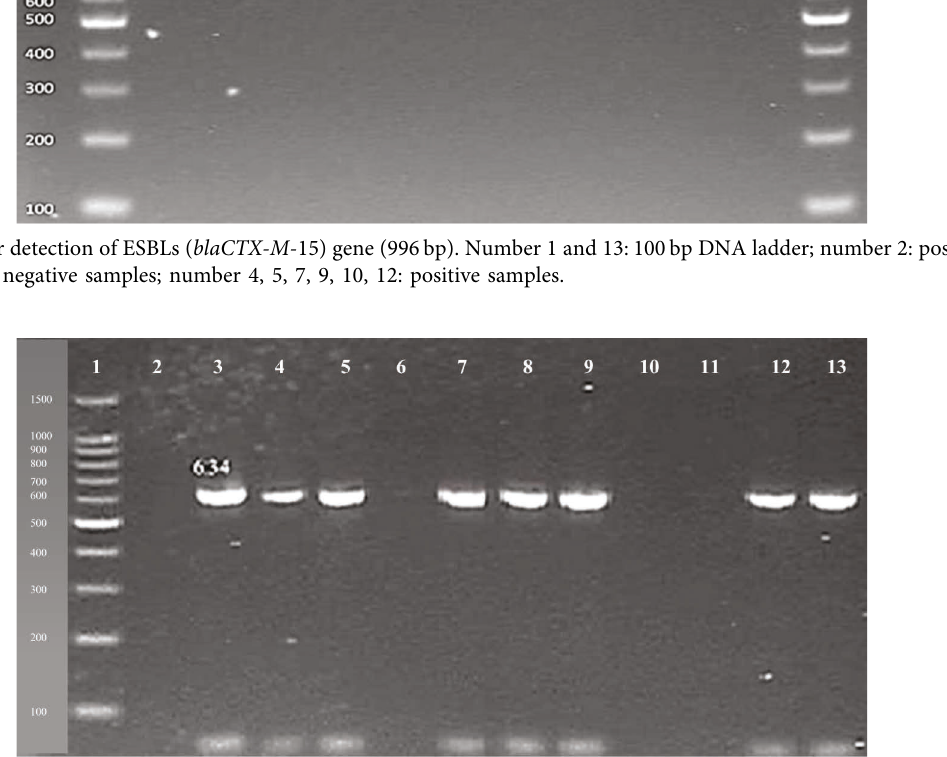
Figure 4: Molecular detection of tetB drug resistance gene (634 bp). Number 1: 100bp DNA ladder; number 2, 6, 10, 11: negative samples; number 3: positive control; number 4, 5, 7, 8, 9, 12, 13: positive samples.